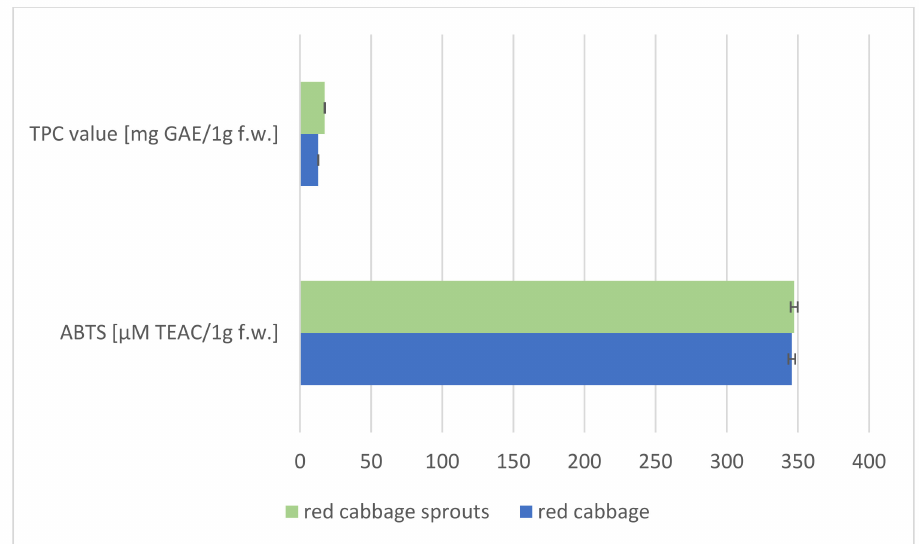
Figure 1. Total polyphenol content (TPC) and antioxidant activity (ABTS) of fresh red cabbage and fresh red cabbage sprouts. The graph shows the mean values and standard deviation ( n = 3).